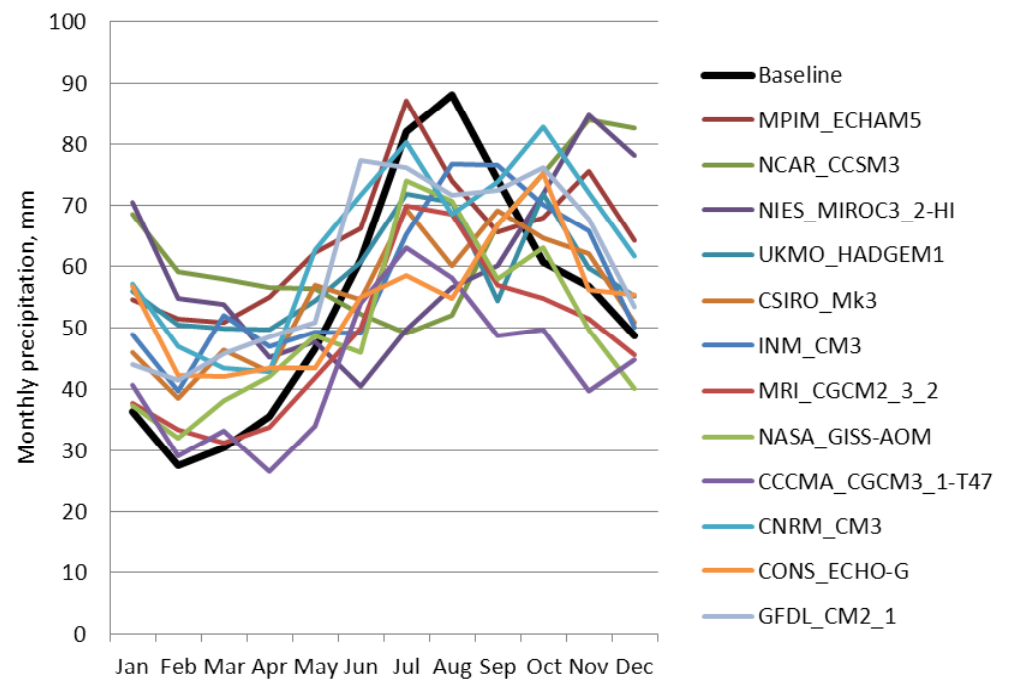
Fig. 3. Observed monthly mean precipitation (baseline) and the modelled values in eastern Estonia using 12 selected GCM outputs from AR4 during the control period